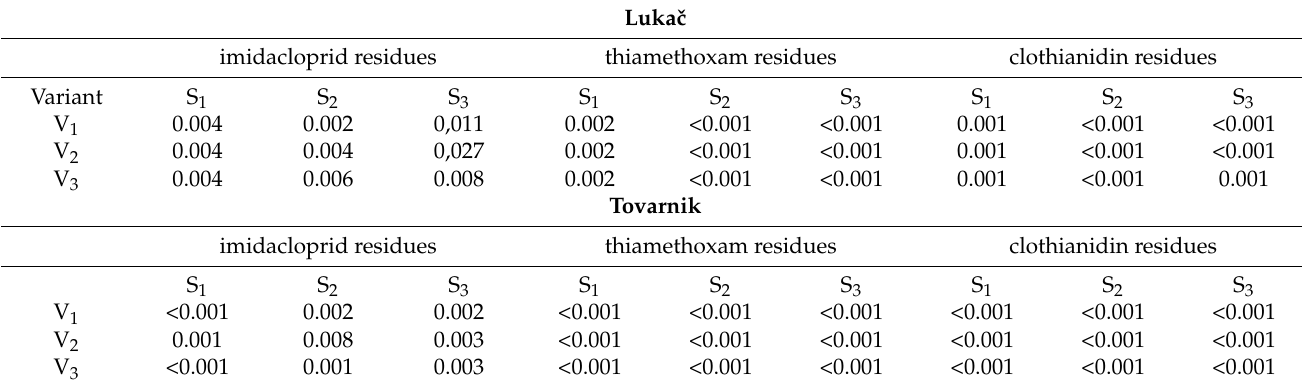
Table 2. Determined residues of neonicotinoids (in mg/kg) in ground beetle samples from different variants collected from sugar beet fields in Lukaˇc and Tovarnik.